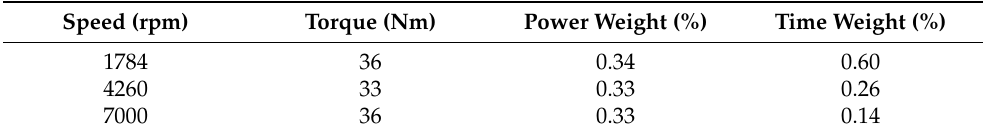
Table 3. 3 characteristic